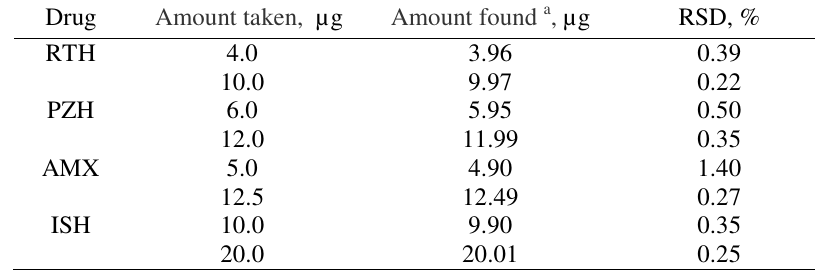
Table 3. Between-day precision of the determination of cited drugs by the proposed method